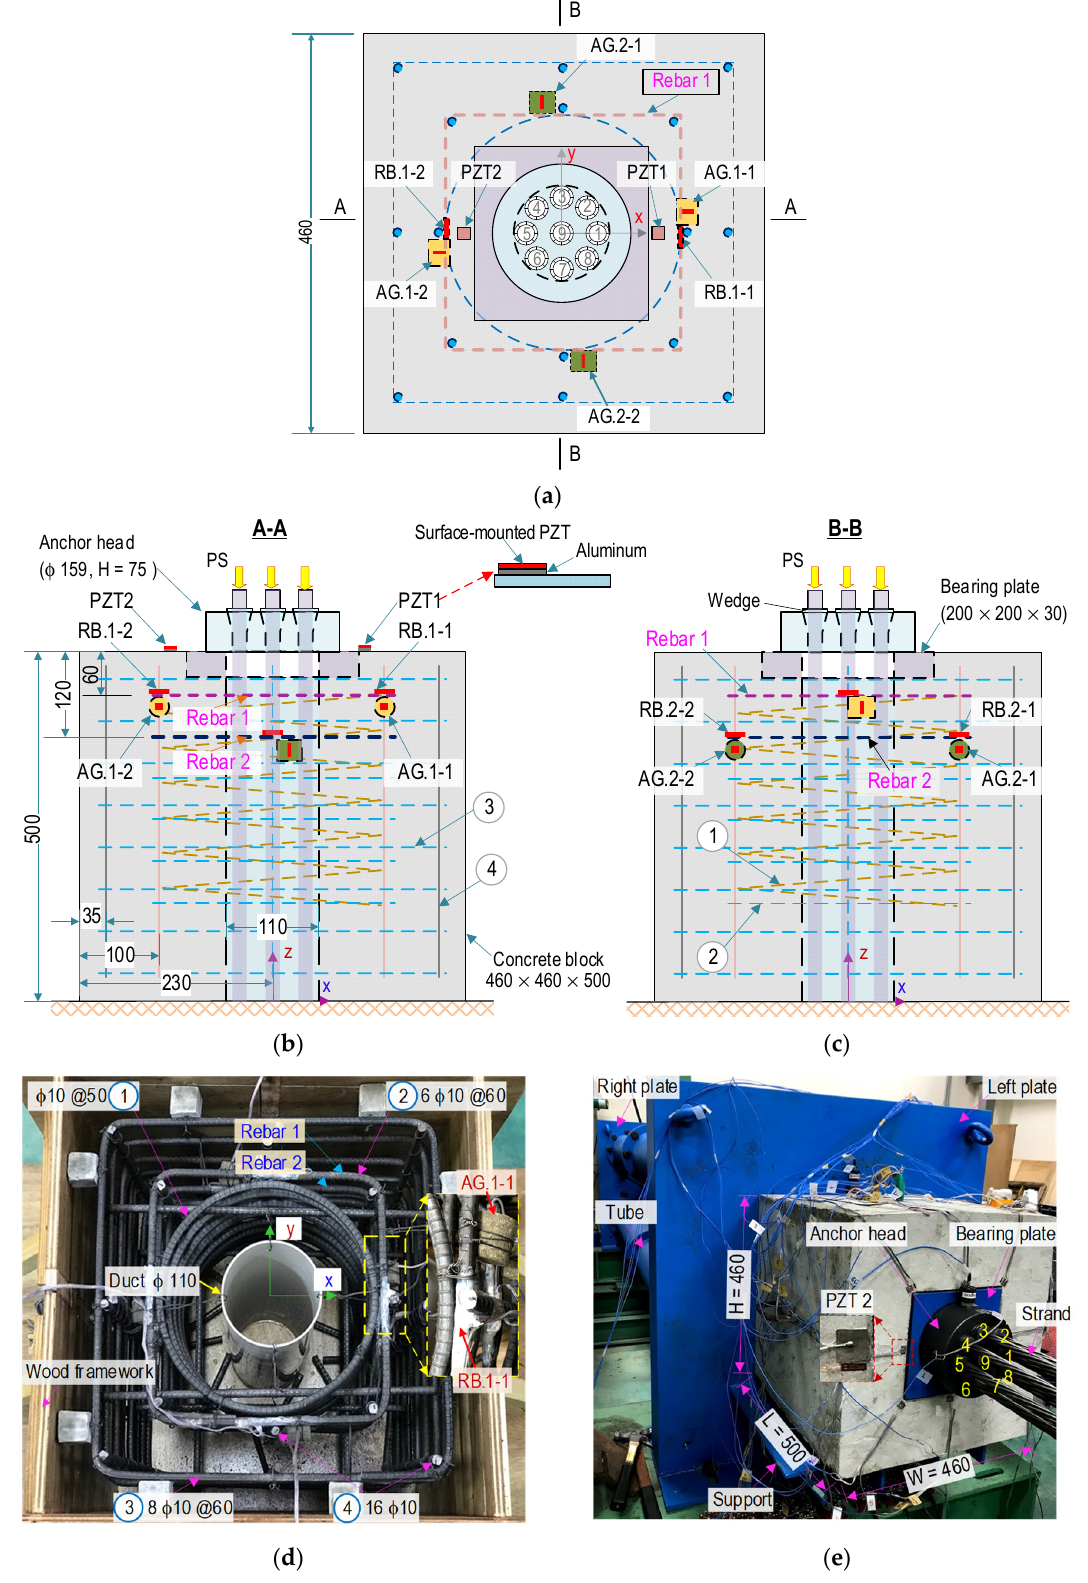
Figure 17. Diagram of PSC anchorage zone installed with smart rebar–aggregates (dimension in mm): ( a ) Top-view of anchorage configuration; ( b ) Cross-sectional A-A; ( c ) Cross-sectional B-B; ( d ) Reinforcement and sensor installation; ( e ) Experimental setup of PSC anchorage.